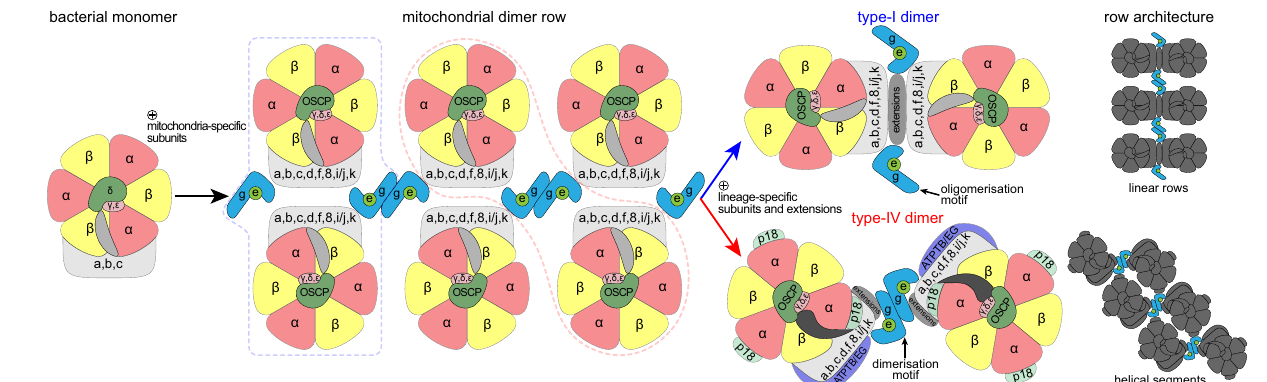
Fig. 8 | The subunit- e/g module is an ancestral oligomerization motif of ATP synthase. Schematic model of the evolution of type-I and IV ATP synthases. Mitochondrial ATP synthases are derived from a monomeric complex of proteo- bacterial origin. In a mitochondrial ancestor, acquisition of mitochondria-speci fi c subunits, including the subunit- e/g module resulted in the assembly of ATP